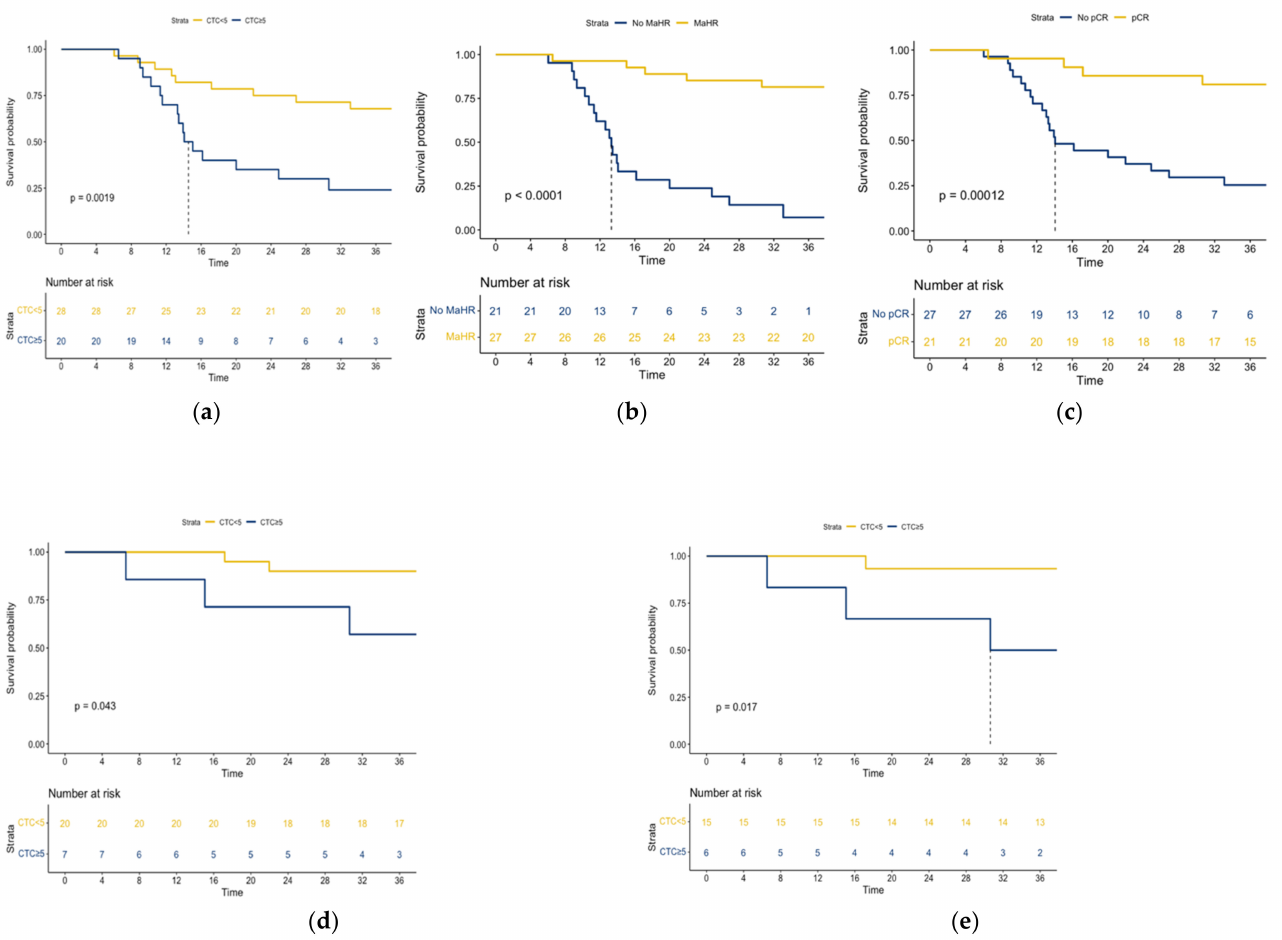
Figure 2. Kaplan-Meier plots of overall survival in patients with ( a ) ≥ 5 CTCs per mL of blood versus less than 5 CTCs per mL of blood, ( b ) MaHR versus no MaHR and ( c ) pCR versus no pCR in the entire study cohort ( n = 48). Kaplan-Meier plots of overall survival in patients with ≥ 5 CTCs per mL of blood versus less than 5 CTCs per mL of blood in ( d ) patients who achieved MaHR ( n = 27) and ( e ) patients who achieved pCR ( n =